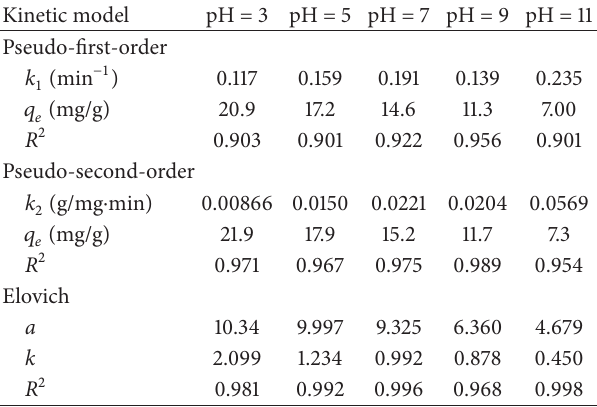
Table 1: Parameters for the nonlinear kinetic models including pseudo-first-order, pseudo-second-order, and Elovich models. Kinetic